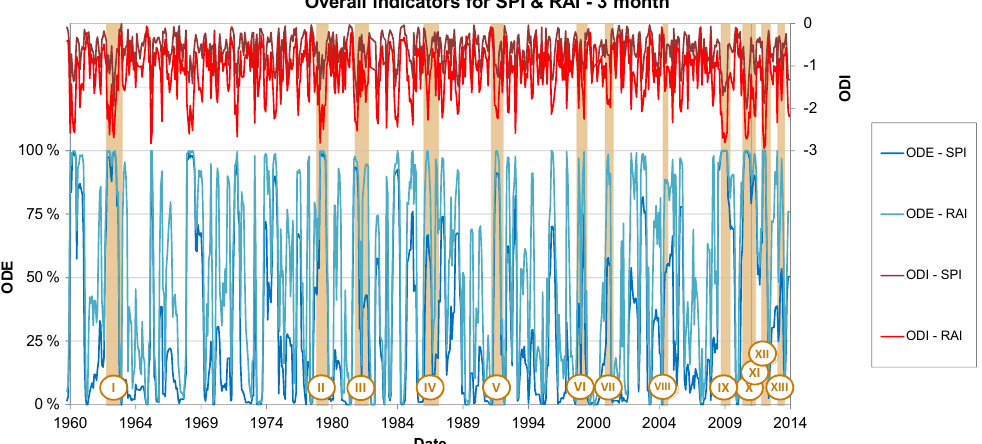
Figure A3. ODE and ODI values using the 3-month timescales of SPI and RAI indices, compared with the 13 detected historical droughts (in orange).